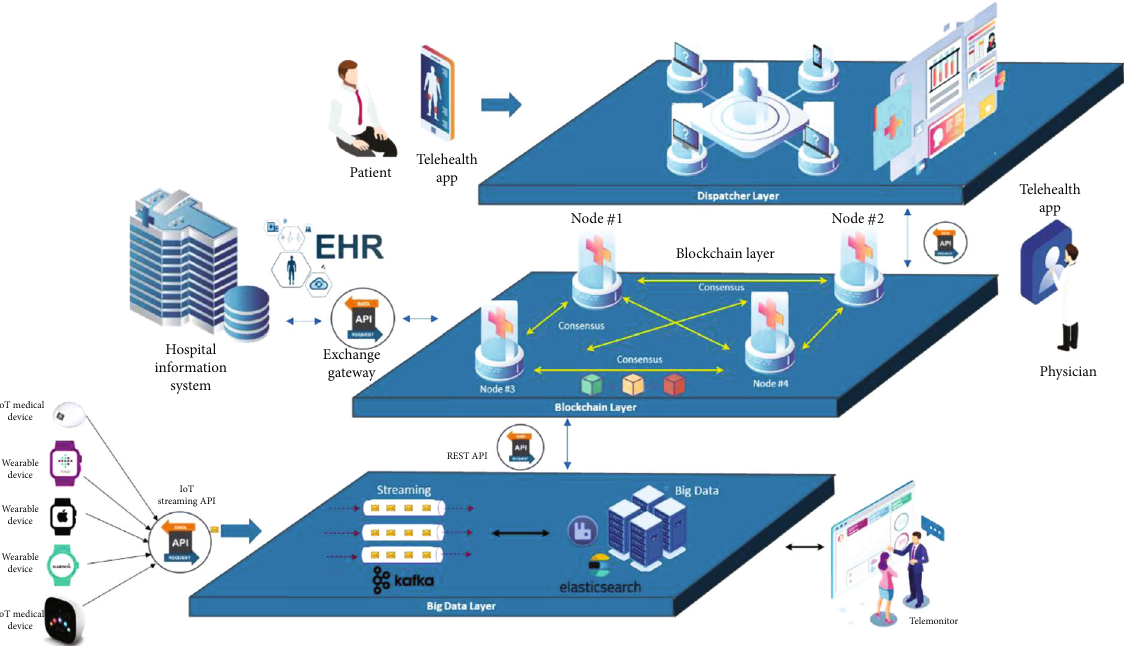
Figure 7: Software architecture design for a large-scale telehealth